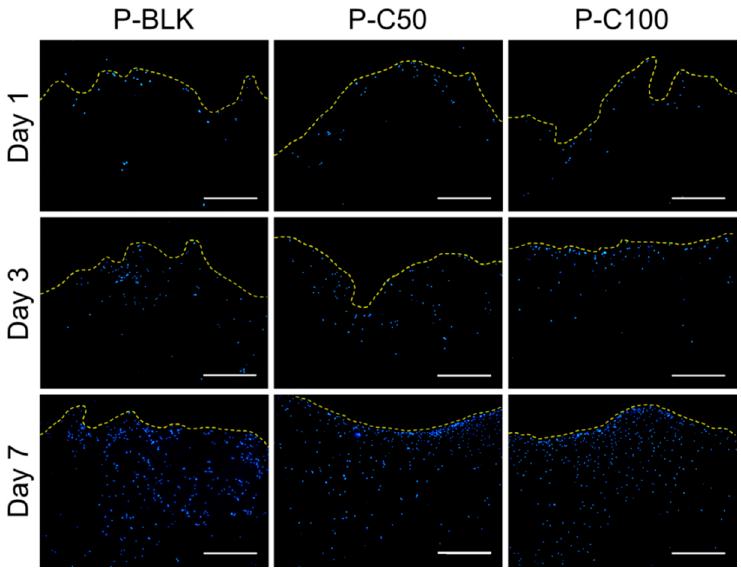
Figure 3. Fluorescence microscope images of 4’,6-diamidino-2-phenylindole (DAPI) stained cross-sections of P-BLK, P-C50, and P-C100 scaffolds seeded with human dermal fibroblasts (HDFs) on day 1, 3, and 7. The yellow dotted lines indicate the top margin of scaffolds. Section thickness = 30 µm. Scale bar = 500 µm.